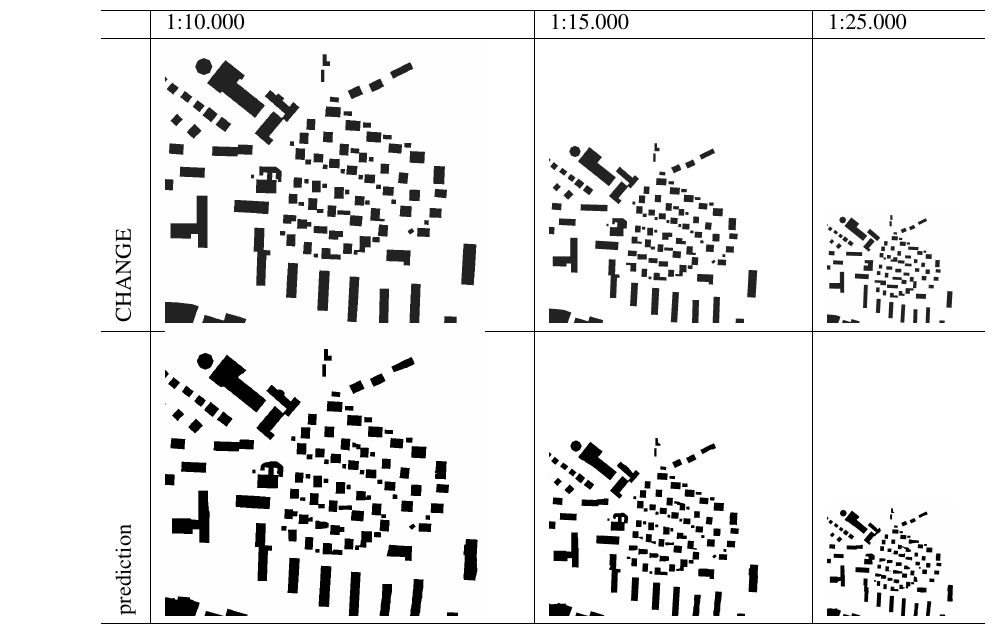
Figure 12. comparison of target scales (top) and predicted presentations (bottom): visualization original target scale